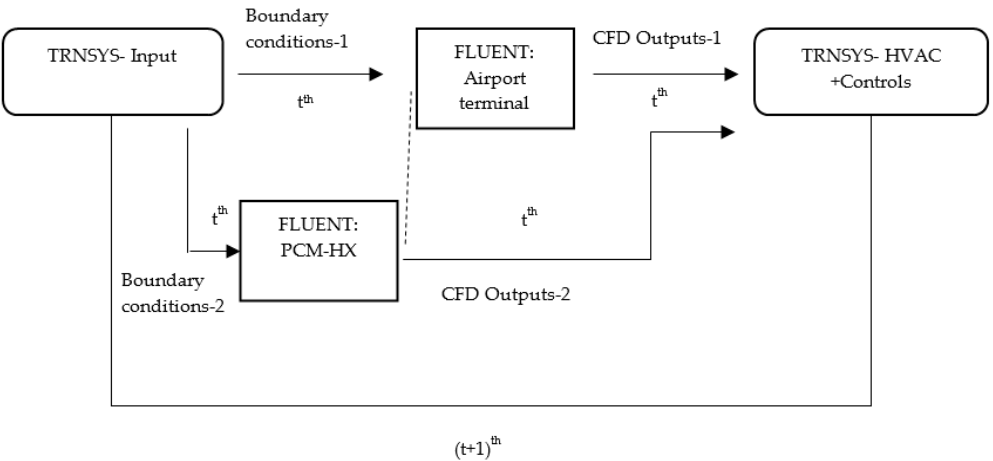
Figure 11. The diagram of TRNSYS-CFD coupled simulation [122].